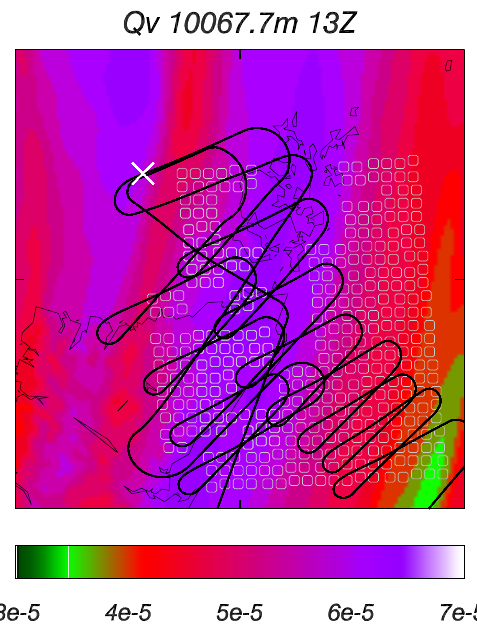
Figure 6. The UKV-model-predicted field of the water vapour mix- ing ratio ( Q v ) on 25 January 2010 at 13:00UTC, between latitudes 57.8 and 59.7 ◦ and longitudes − 5.3 and − 1.8 ◦ . The units of Q v are KgKg − 1 . The PARASOL pixels are represented by the open circles and the aircraft track is represented by the solid line, and X marks the location where the aircraft was directly above the cloud at about 13:33:00UTC.